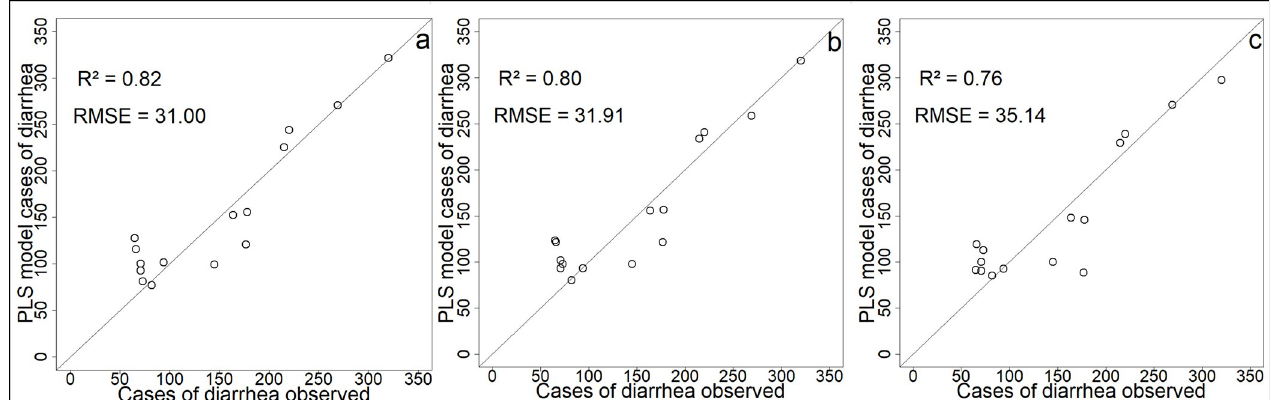
Fig 13. Comparison of models’ predictions with cases of diarrhea observed (a) PLS model with all environmental variables; (b) PLS model with Monthly rainfall, SPM, E . coli , NIR Band, and NDVI; (c) PLS model with NIR band, NDVI and Monthly rainfall.